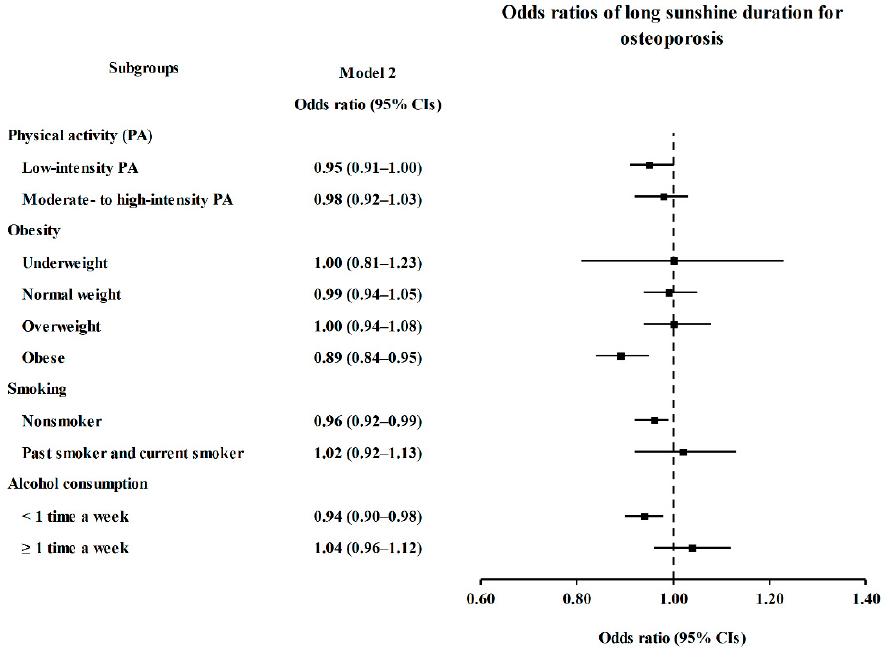
Figure 3. Subgroup Analyses of Long Sunshine Duration for Osteoporosis According to Physical Activity, Obesity, Smoking, and Alcohol Consumption Visualized by Forest